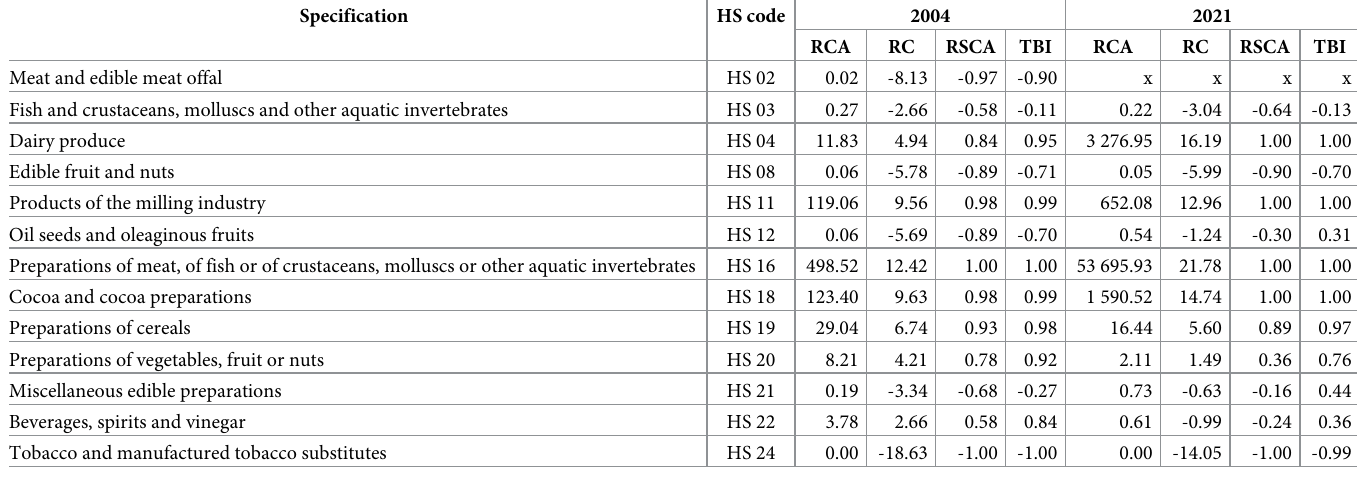
Table 7. Comparative advantages of Polish agri-food sector in trade with the USA in 2004 and 2021.